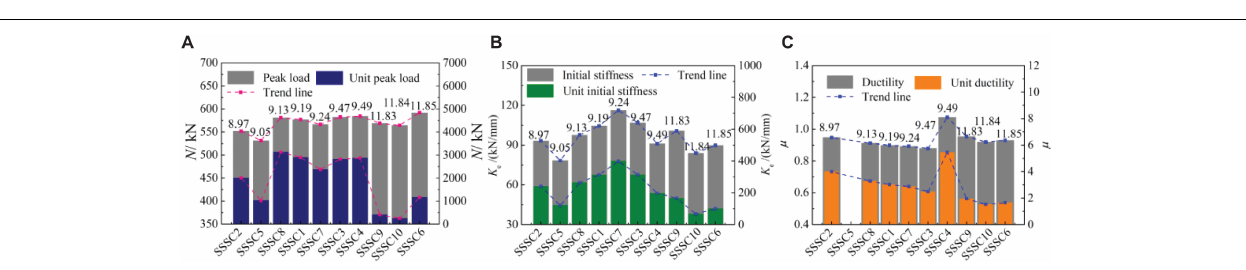
FIGURE 11 | Effect of aspect ratio. (A) Variation of peak load, strain, and energy dissipation. (B) Stiffness degradation and ductility.